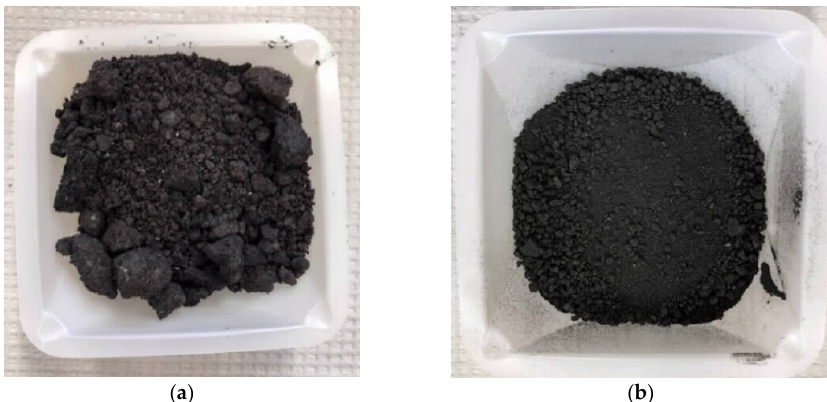
Figure 2. ZPR as is and after washing with water. ( a ) Raw residue after drying; ( b ) Residue after washing and drying.